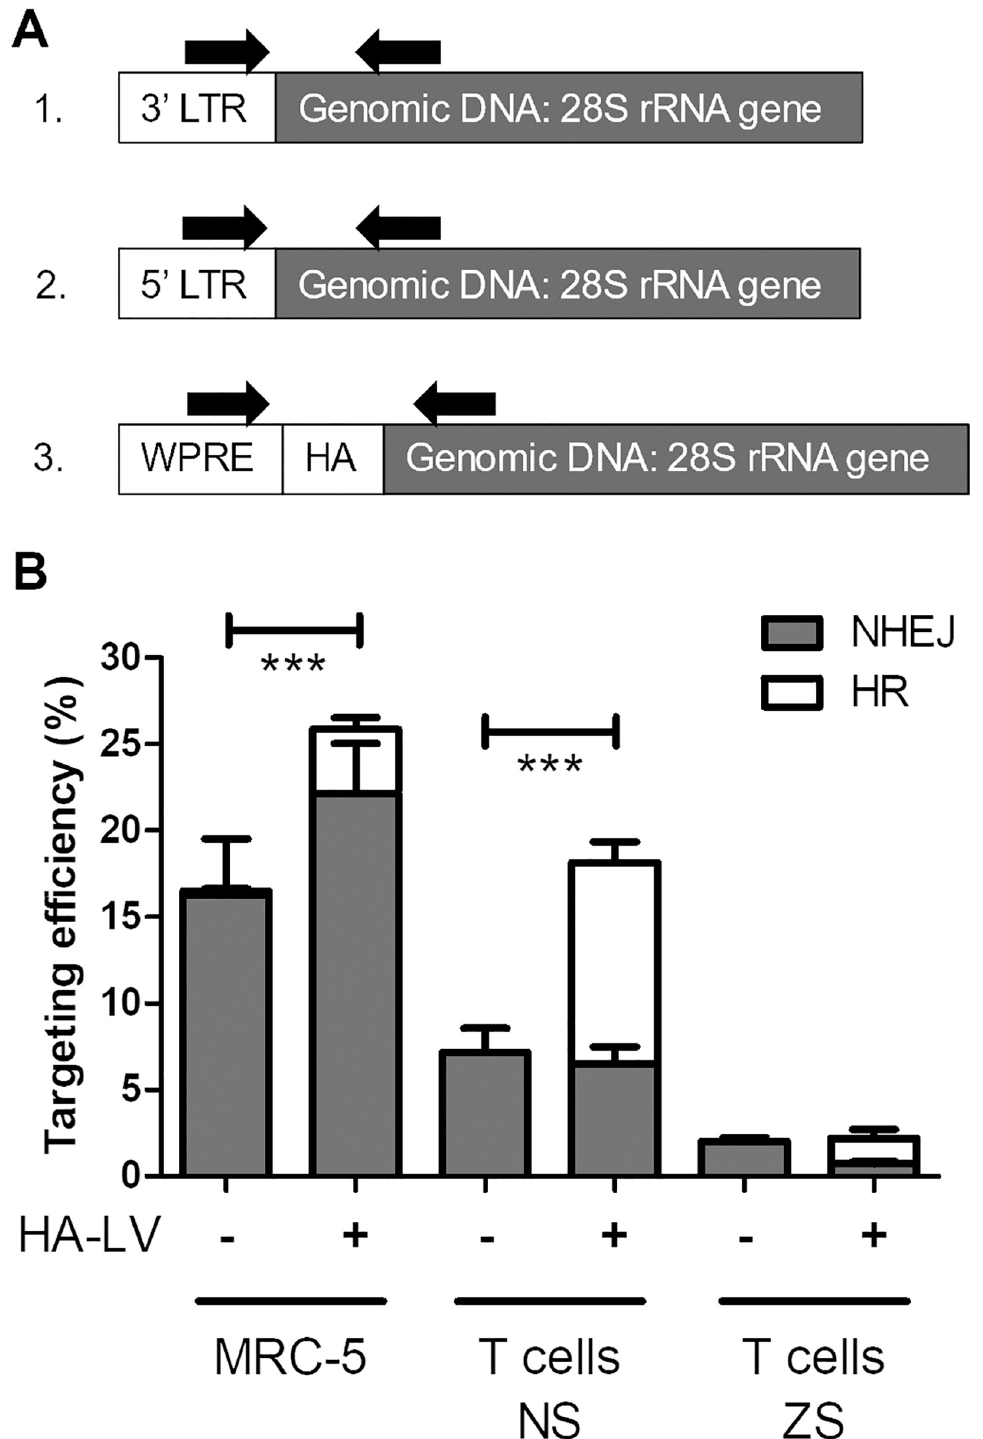
Fig 3. Analysis of targeted insertion by droplet digital PCR (ddPCR). A . An illustration of the three separate assays used to measure targeted insertion: 1. Transgene insertion via non-homologous end-joining (NHEJ) in the sense orientation; 2. Transgene insertion via NHEJ in the antisense orientation; and 3. Homologous recombination (HR). Arrows denote primer binding sites. B . Overall insertion targeting efficiency of D+H LVs into the 28S rRNA gene as assessed with ddPCR in the MRC-5 cell line (n = 9), primary human T cells with no antibiotic selection (NS) (n = 6) and Zeocin-selected (ZS) T cells (n = 6) on days 9 (MRC-5) and 10 (T cells) post-transduction, measured in samples with